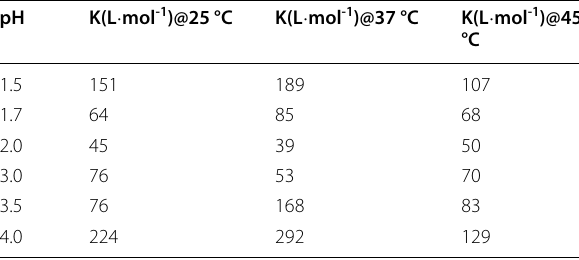
Table 2 Stability constants of RDV / SBE‑β‑CD inclusion complexes